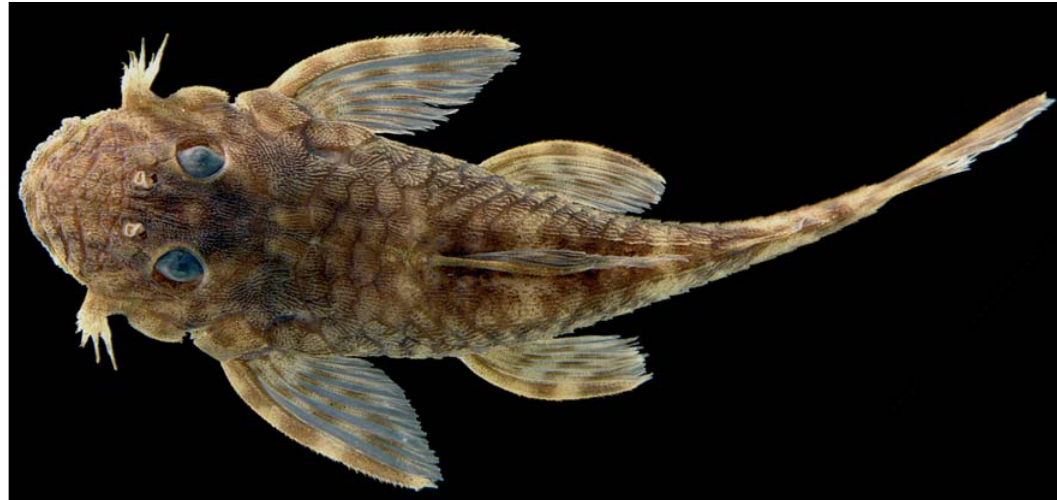
Fig 3. Lithoxus lithoides , AUM 39040, 49.0 mm SL, Guyana, Essequibo River at Yukanopito